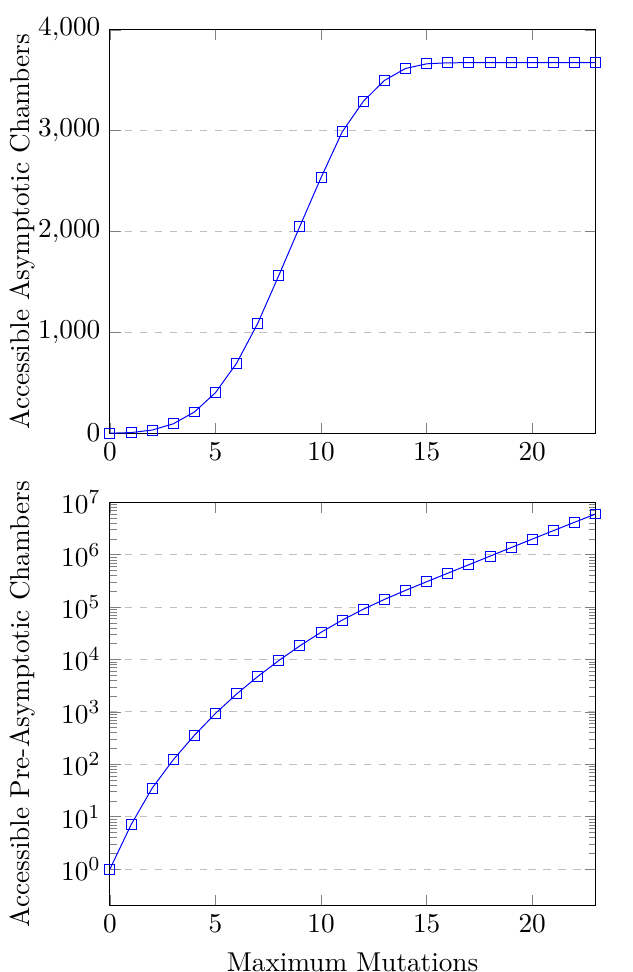
Figure 19. Number of accessible asymptotic and pre-asymptotic chambers after a maximum of X mutations from the initial pre-asymptotic chamber. Note that we are only considering (pre- )asymptotic chambers on one side on the limiting